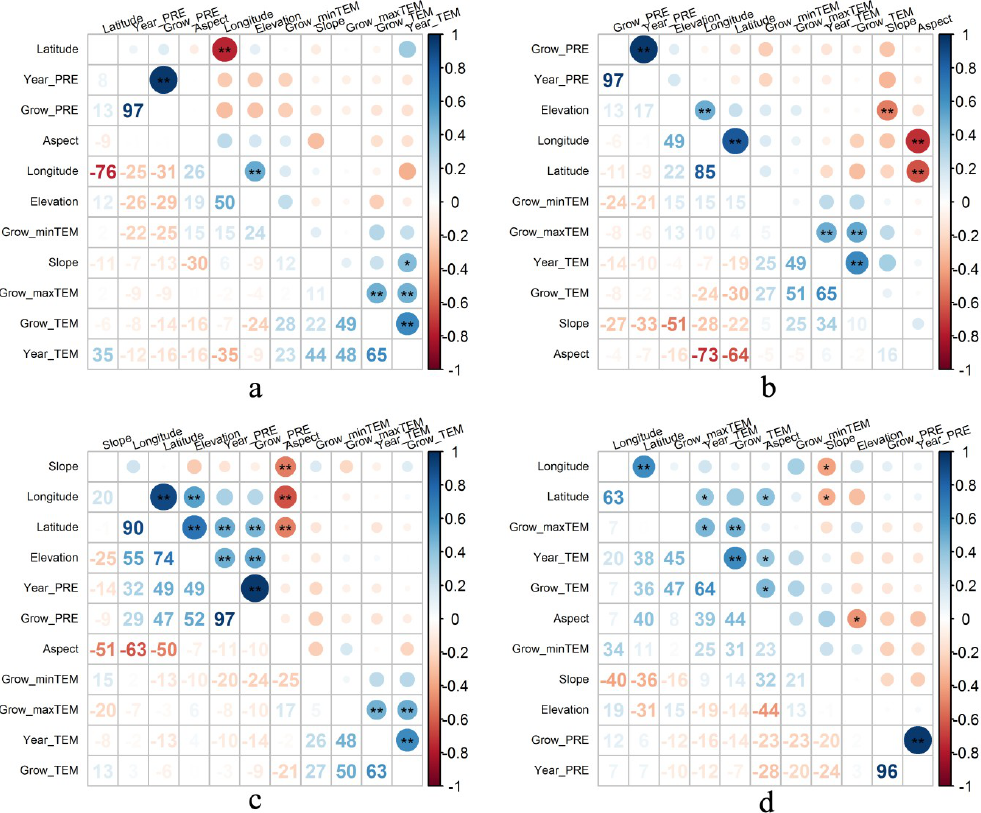
Figure 9. Relationship between the nearest alpine timberline and meteorological and topographic factors on: ( a ) the first hillside, ( b ) the second hillside, ( c ) the third hillside, and ( d ) the fourth hillside. Note: Figure 1 shows the locations of hillsides 1 – 4; ** and * indicate significance coefficients of less than 0.01 and 0.05, respectively.